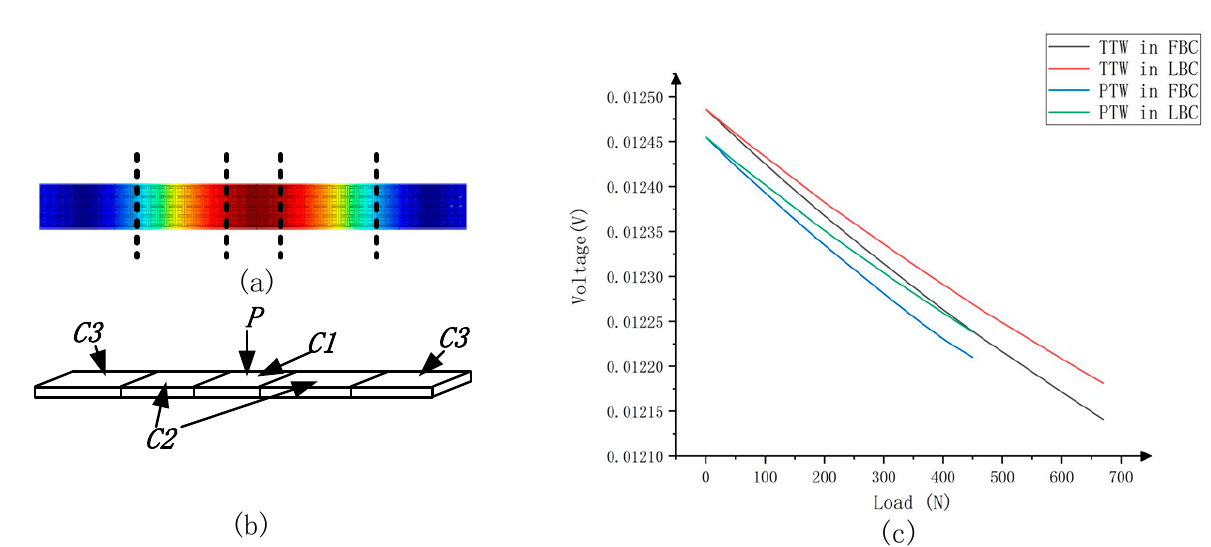
Figure 9. ( a ) Strain cloud diagram of the displacement field; ( b ) schematic diagram of the division of Ci (I = 1,2,3); ( c ) PTW, TTW structure electromagnetic simulation results.